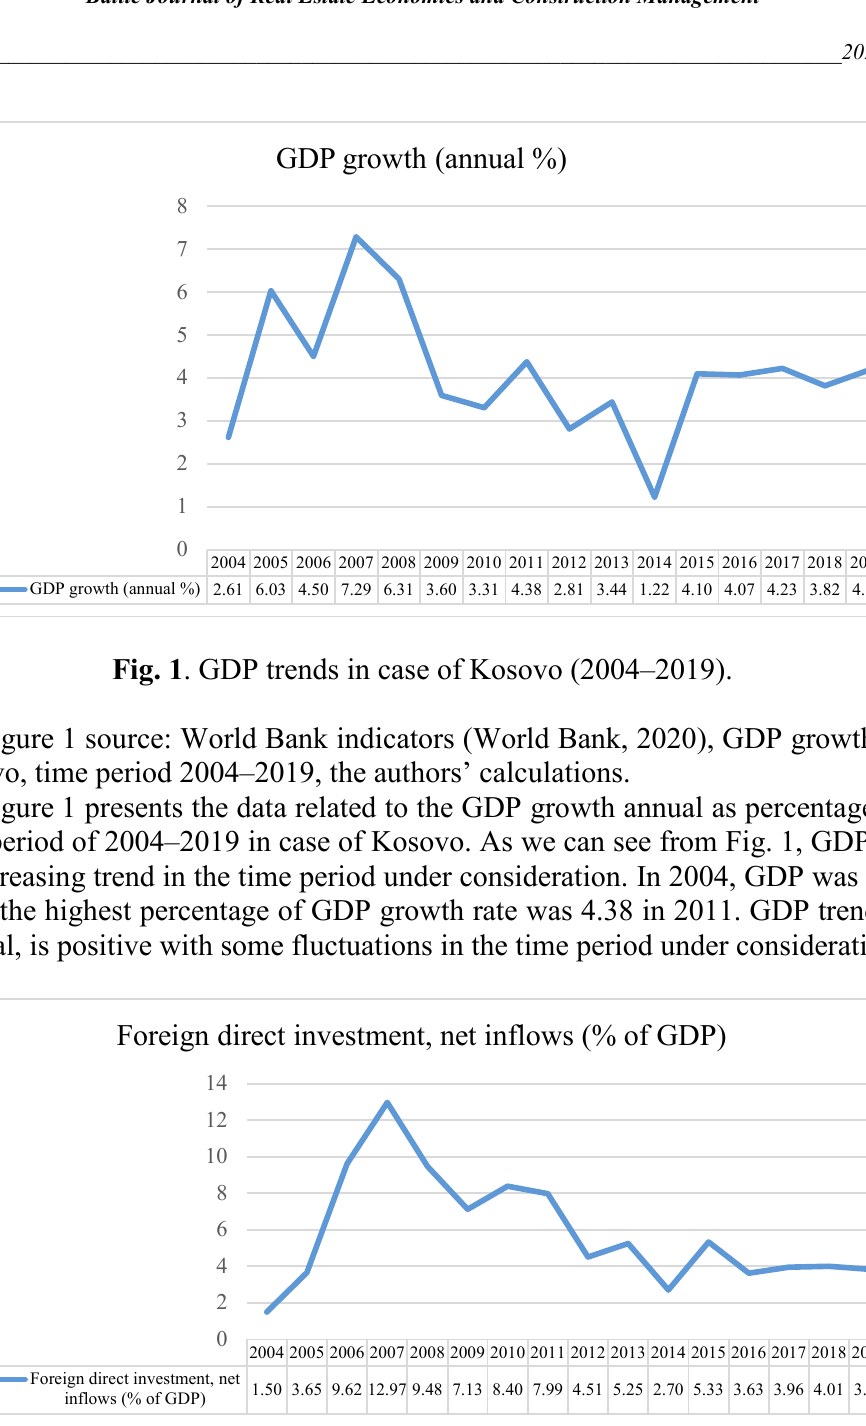
Fig. 2 . FDI trends in case of Kosovo (2004–2019). Figure 2 source: World Bank indicators (World Bank, 2020), FDI growth rate for Kosovo, time period 2004–2019, the authors’